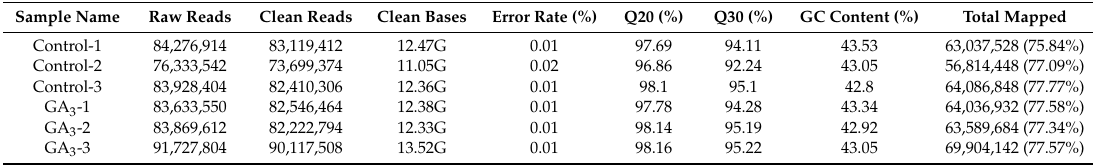
Figure 3. Effect of injecting plants with GA 3 on sugars content and soluble protein content in 1 cm-thick stems of garlic: ( A ) soluble sugar, ( B ) soluble protein, ( C ) sucrose, ( D ) glucose, and ( E ) fructose. Values are the means ± SD ( n = 4) and Student’s t-test was used to determine significant difference at the same period between the control group and GA 3 treatment group. Significance levels: * p < 0.05. Table 1. Transcriptome data output quality